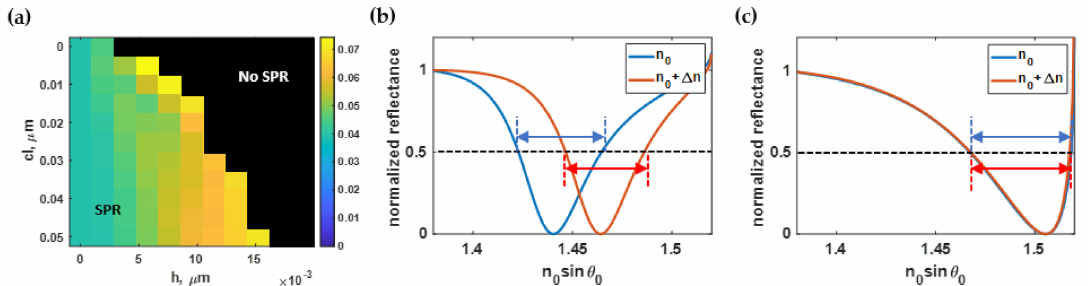
Figure 10. ( a ) The full width at half maximum in rad/ µ m calculated using Monte Carlo simulation, ( b ) SPR dips at h of 1 nm and cl of 50 nm with an average FWHM of 0.04 rad/ µ m; and ( c ) SPR dips at h of 7 nm and cl of 15 nm with an average FWHM of 0.05 rad/ µ m.